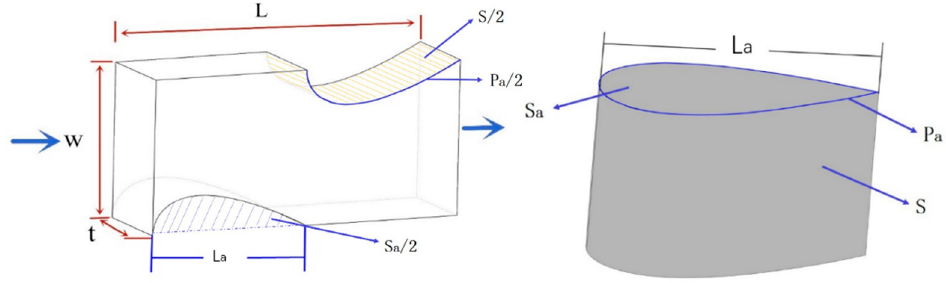
Figure 6. Schematic diagram for calculation of hydraulic diameter.